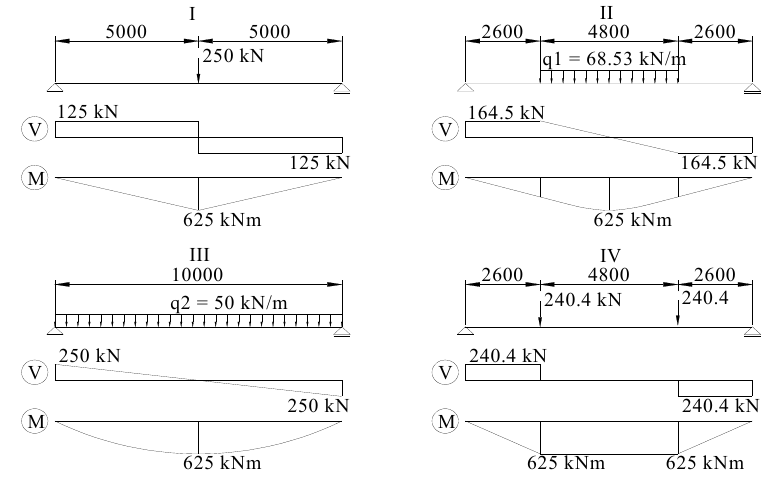
Figure 6. Shear force and moment diagram of four load cases.